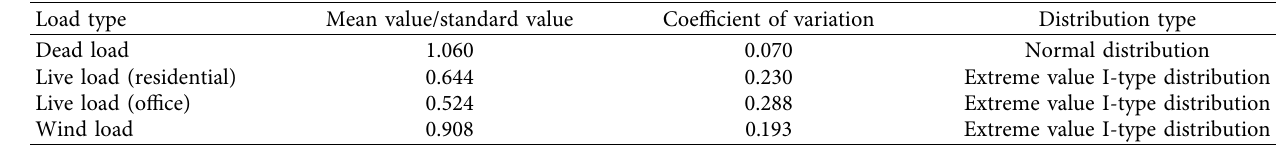
Table 5: Statistical parameters of external load.